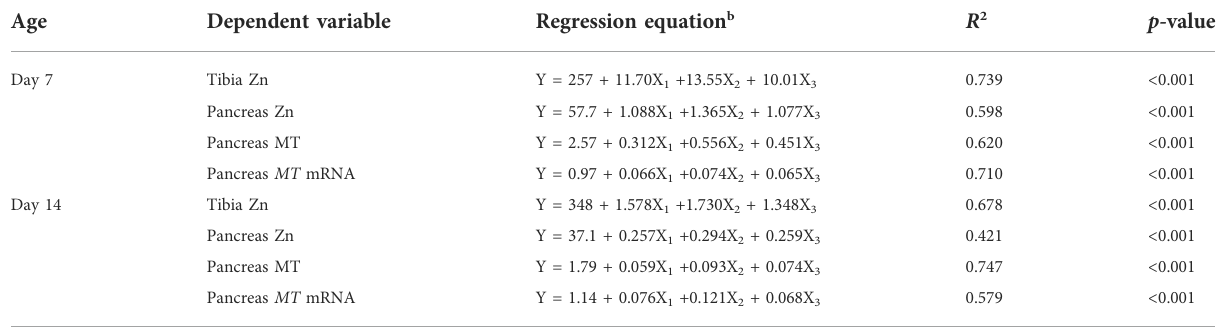
TABLE 6 Multiple linear equation of different Zn sources a